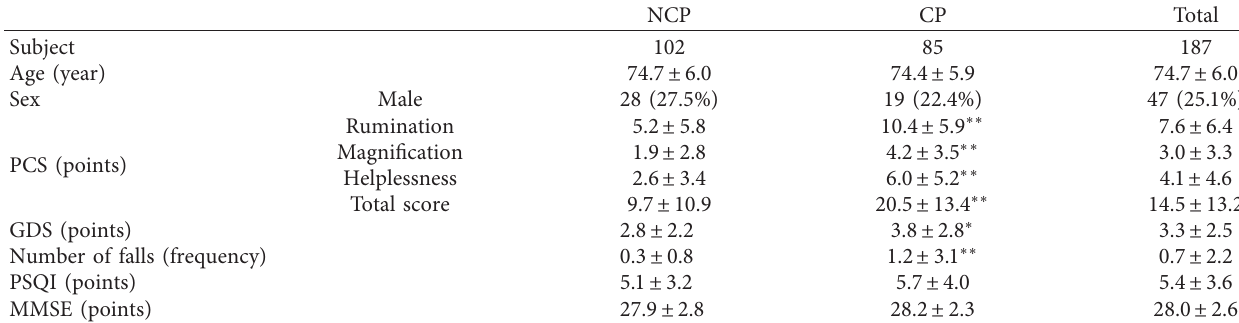
Table 1: Comparison between groups based on chronic pain.